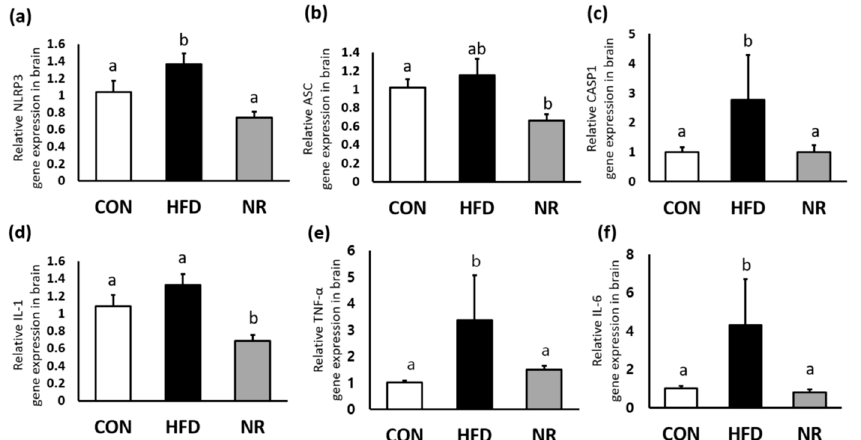
Figure 1. The effects of nicotinamide riboside (NR) on the nucleotide binding and oligomerization domain-like receptor family, pyrin domain containing 3 (NLRP3) inflammasome components and inflammatory markers in whole brains of mice. Relative gene expression of ( a ) NLRP3 , ( b ) apoptosis- associated speck-like protein containing a caspase recruitment domain ( ASC ), ( c ) caspase 1 ( CASP1 ), ( d ) interleukin ( IL)-1 , ( e ) tumor necrosis factor (TNF)- α , and ( f ) IL-6 . Values represent the mean ± SEM ( n =